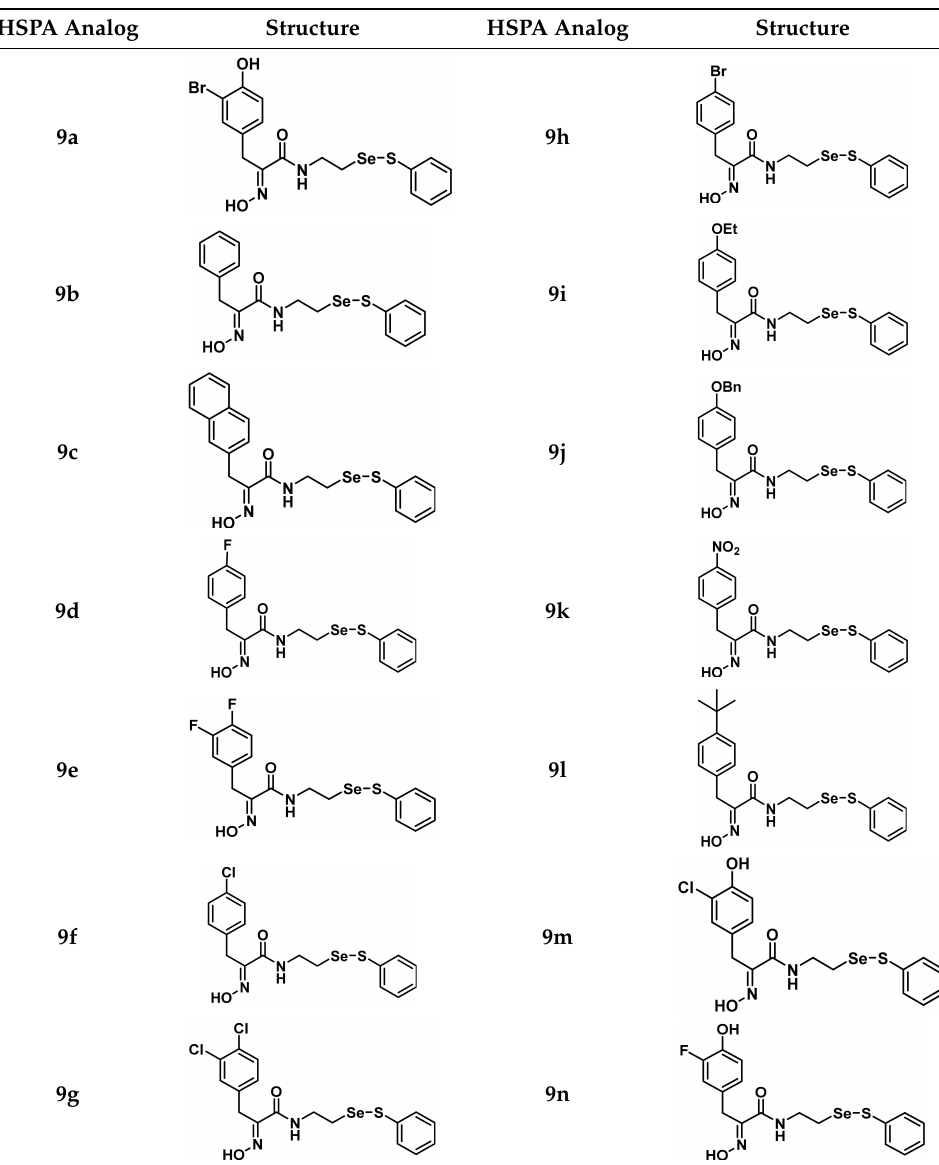
Table 1. Chemical structures of half-selenopsammaplin A (HSPA)